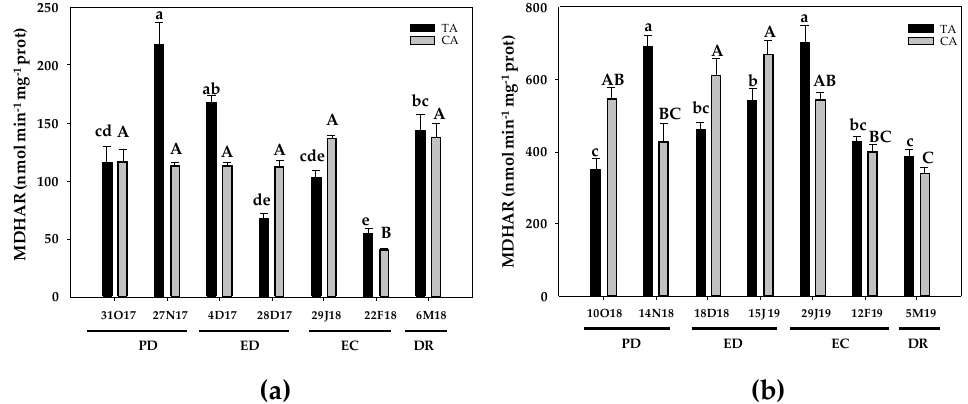
Figure 8. Evolution of monodehydroascorbate reductase (MDHAR) activity in flower buds of peach ‘GEM020’ cultivated in two different geographical areas during the dormancy cycle on two seasons. ( a ): season 1 (2017–2018); ( b ): season 2 (2018–2019). Data represent the mean ± SE, n = 5. Different letters (lowercase and uppercase for the samples of the temperate (TA) and the cold area (CA), respectively) indicate significant differences according to Tukey’s multiple test ( p ≤ 0.05). PD: paradormancy; ED: endodormancy; EC: ecodormancy; DR: dormancy release. FW: fresh weight. The chill units accumulated at the different times and locations are shown in Supplemental file 1.